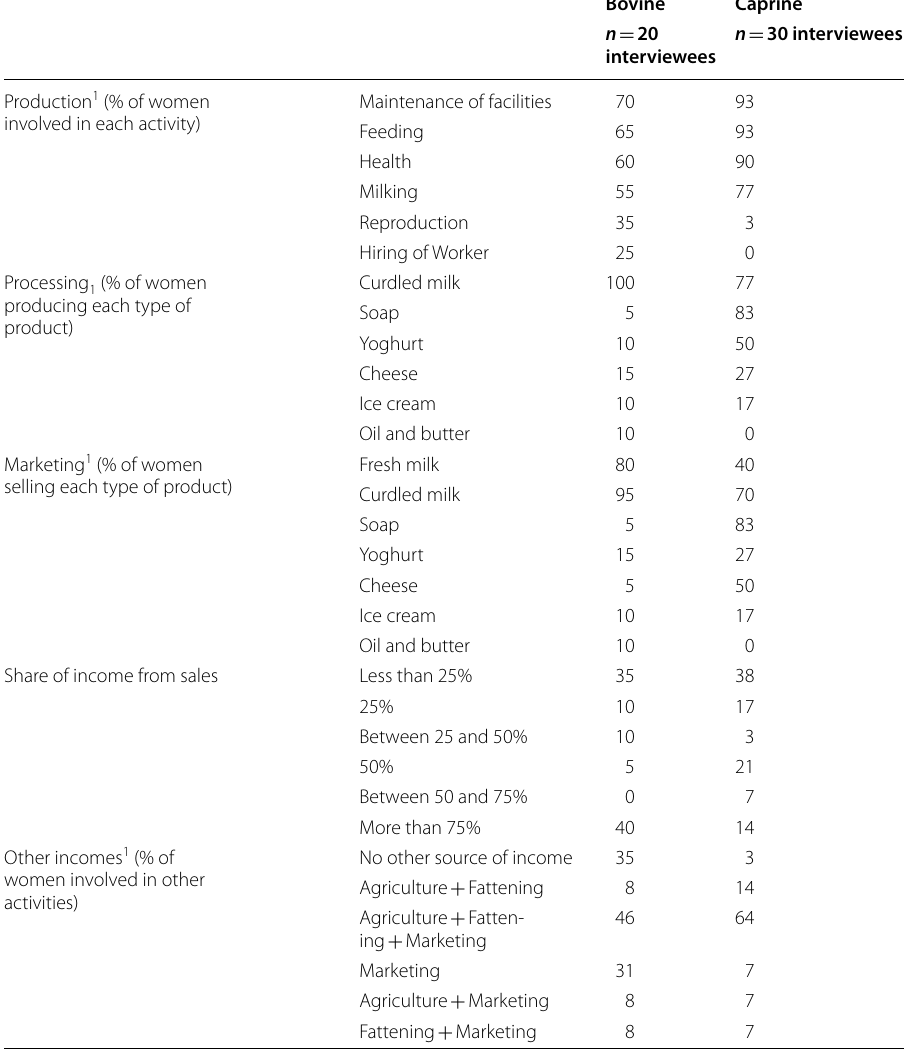
Table 3 Characteristics (in percentage) of women interviewees involved in different activities of bovine and caprine value chains